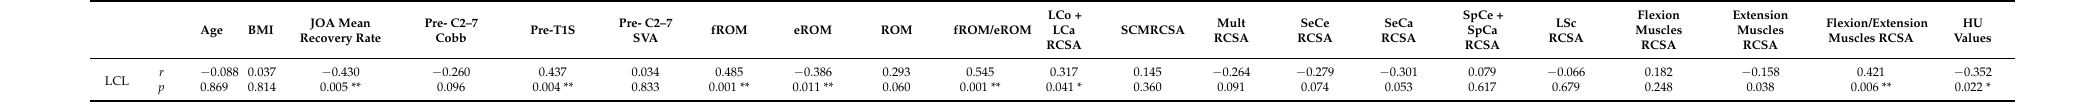
Table 4. Correlation between various factors and